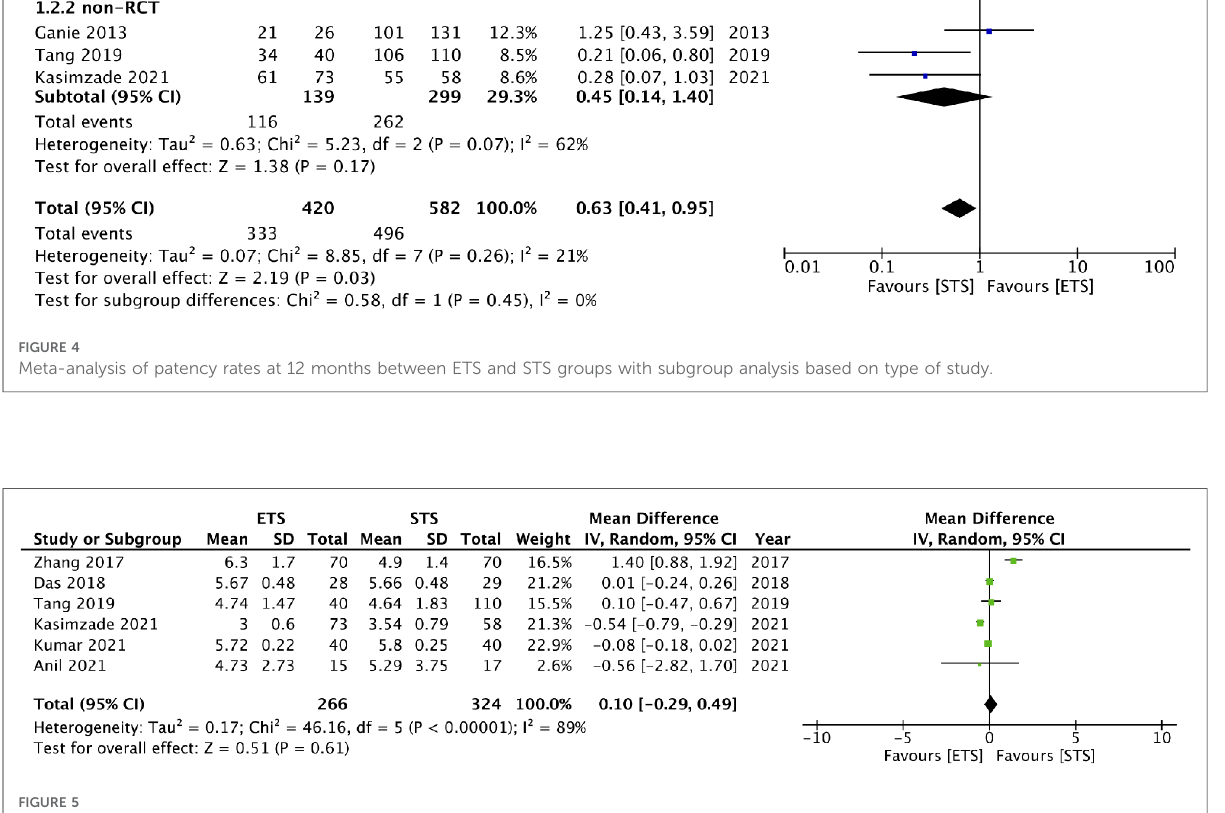
FIGURE 5 Meta-analysis of maturation time in weeks between ETS and STS